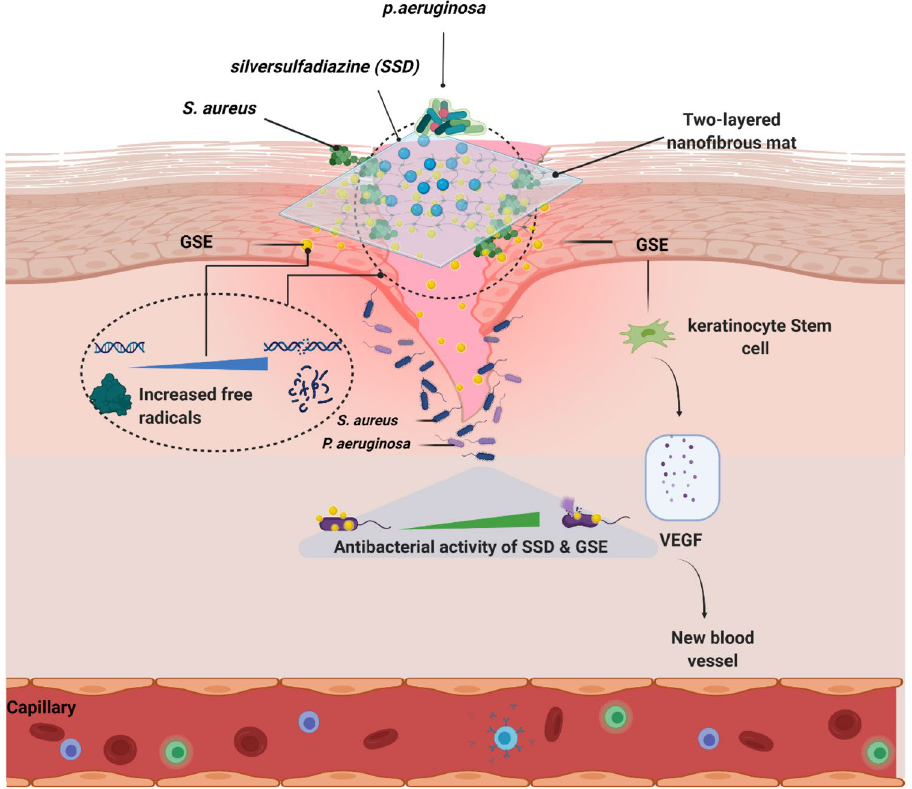
Figure 9. Schematic illustration of the application of a double-layered nanofibrous mat with antibacterial and antioxidant properties to promote wound